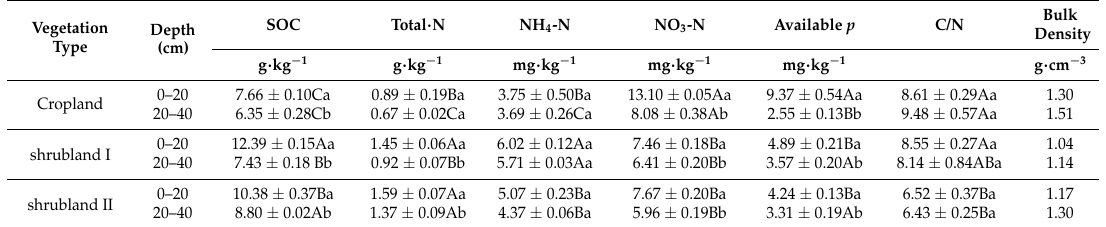
Table 1. Soil chemical and physical properties (mean ± standard error, n =